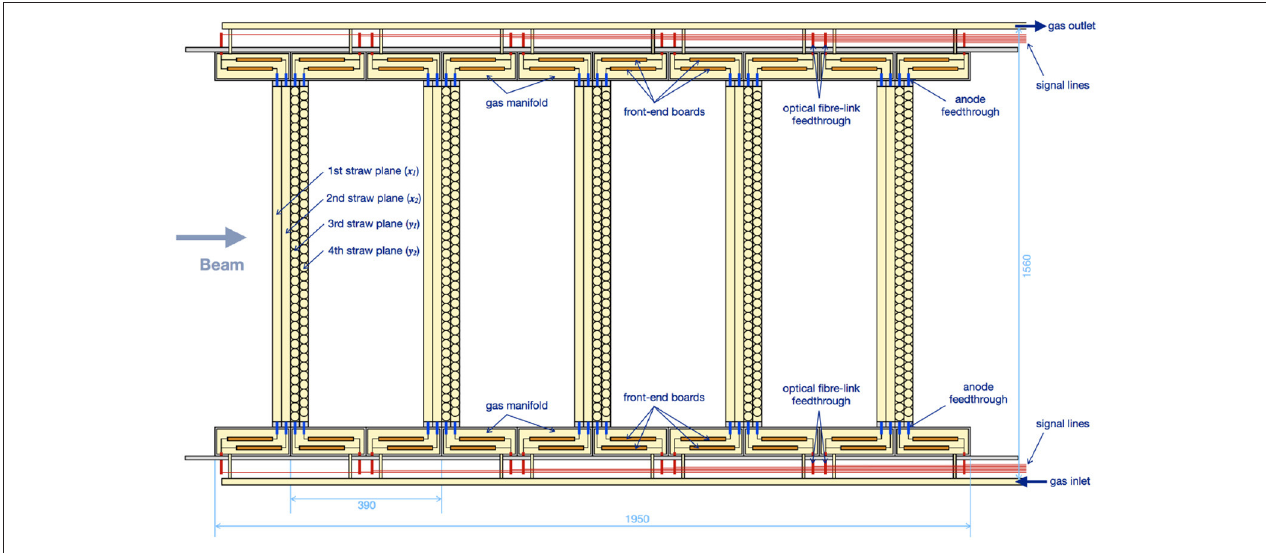
FIGURE 8 | Straw detector configuration for COMET Phase-II experiment.